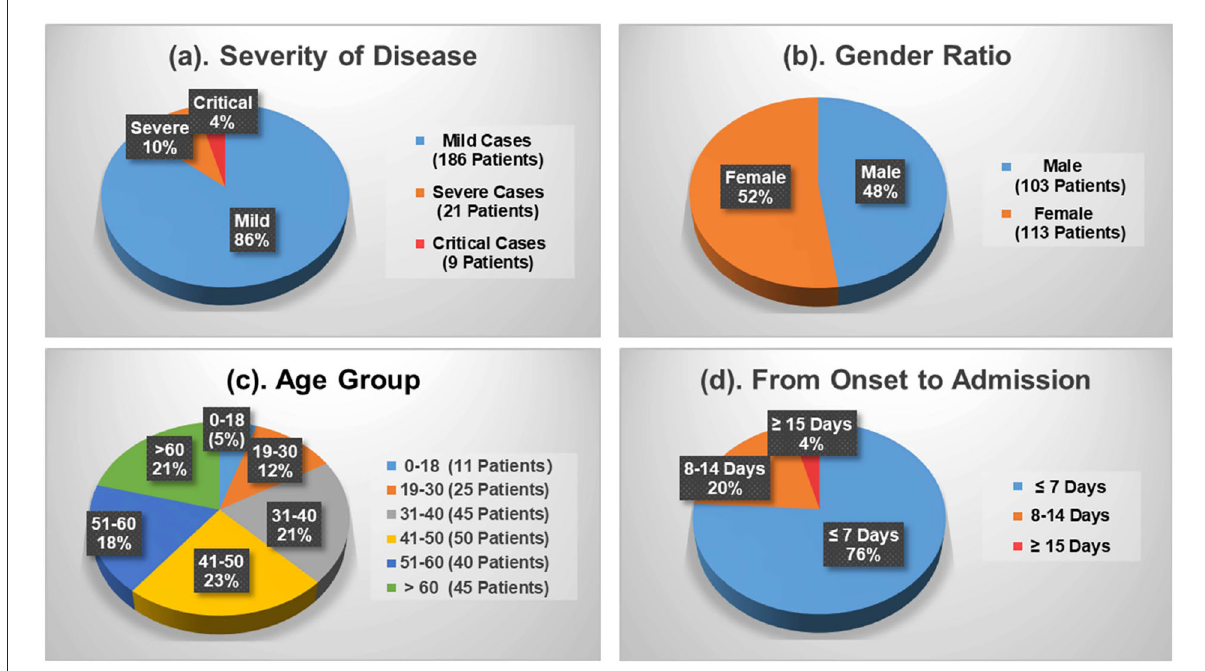
FIGURE1 Demographics of the COVID-19 patients contained in the dataset. (a) Severity of disease. (b) Gender ratio. (c) Age group. (d) From onset to admission.